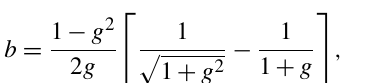
Figure 7. The influence of nitration on (a) the scattering coefficient and (b) absorption coefficient of total particles. The blue and brown lines indicate fresh PBAPs ( S opt12 ) and nitrated PBAPs ( S opt13 ),